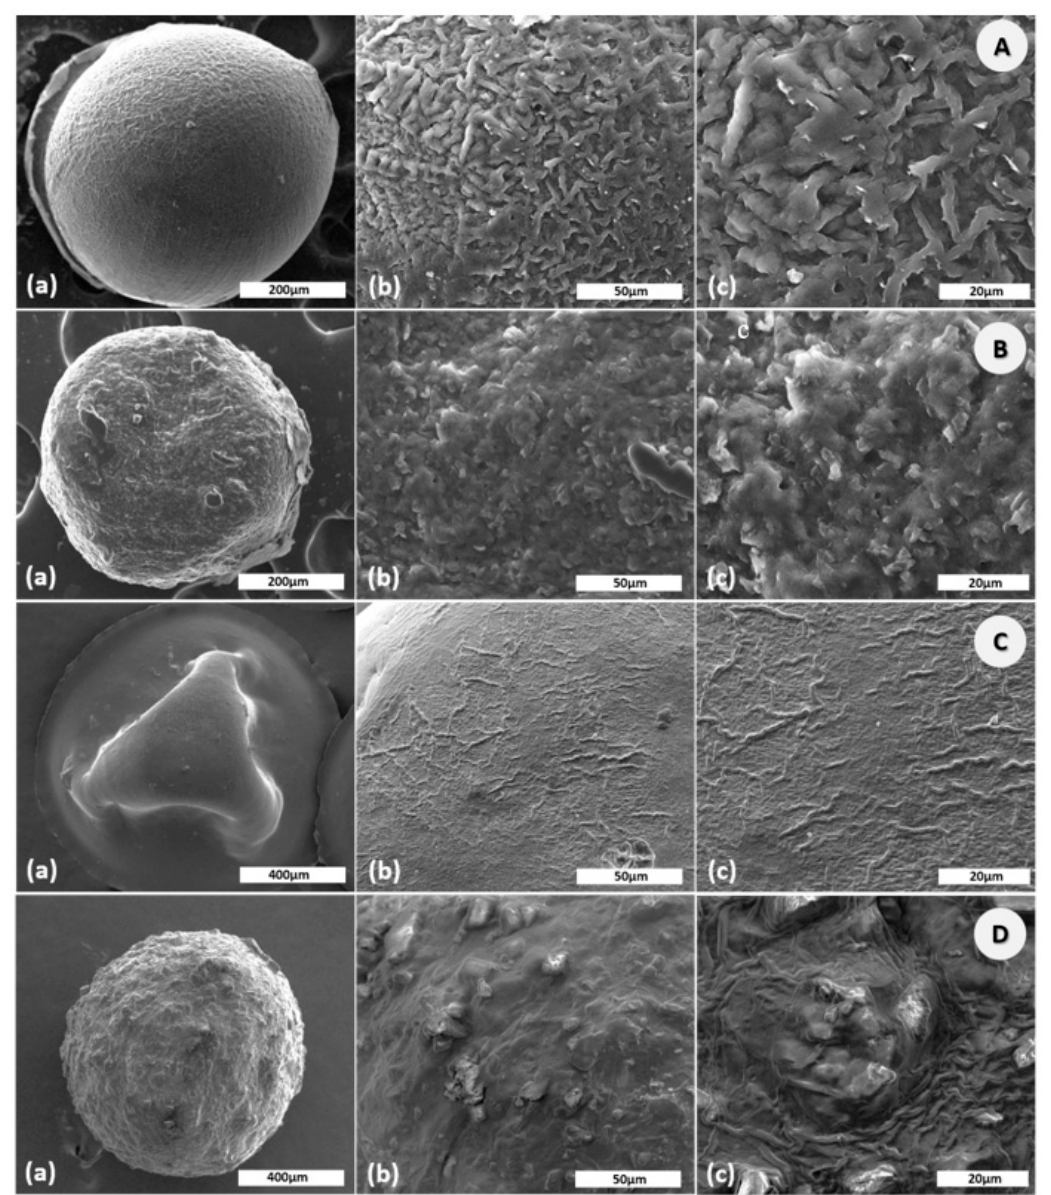
Figure 1. SEM images ofchitosan (CS) ( A ); CS-glibenclamide (Gly) ( B ), CS-lipoic acid (LA) ( C ), CS–Gly–LA( D ) microparticles at different scales: 200/400 μ m (a), 50 μ m (b), 20 μ m (c). The presence of Gly into CS–Gly–LA microparticles was proved by the absorption characteristic − 1 bands corresponding to stretching vibrations for C-H groups from the aromatic ring (2950–2850 cm ), − 1 carbonyl group C = O (1690 cm ), deformation vibrations for secondary amino group NH- − 1 − 1 − 1 (1400–1460 cm ), S = O (1350–1300 cm ) and 1150 cm (C-N). LA was proved into CS–Gly–LA microparticles by the presence of the absorption characteristic bands corresponding to methylene − 1 − 1 − 1 groups CH 2 (2950–2900 cm ), carbonyl C = O (1690 cm ), C-H (1430–1380 cm ), hydroxyl OH − 1 − 1 − 1 (950 cm ), C-S (750–700 cm ), S-S (671 cm )